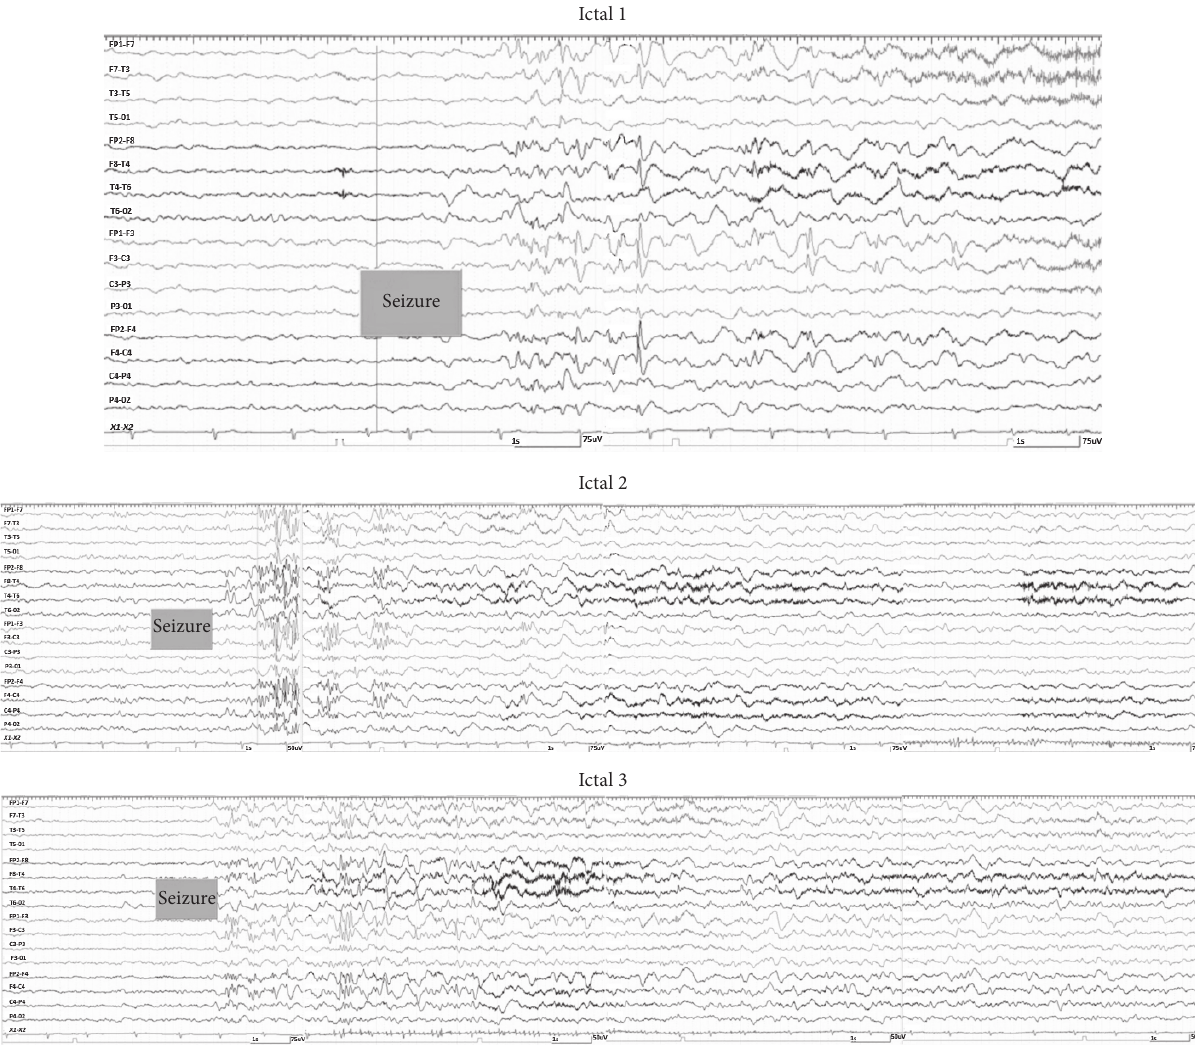
Figure 2: Ictal EEG pattern of the patient during three-seizure